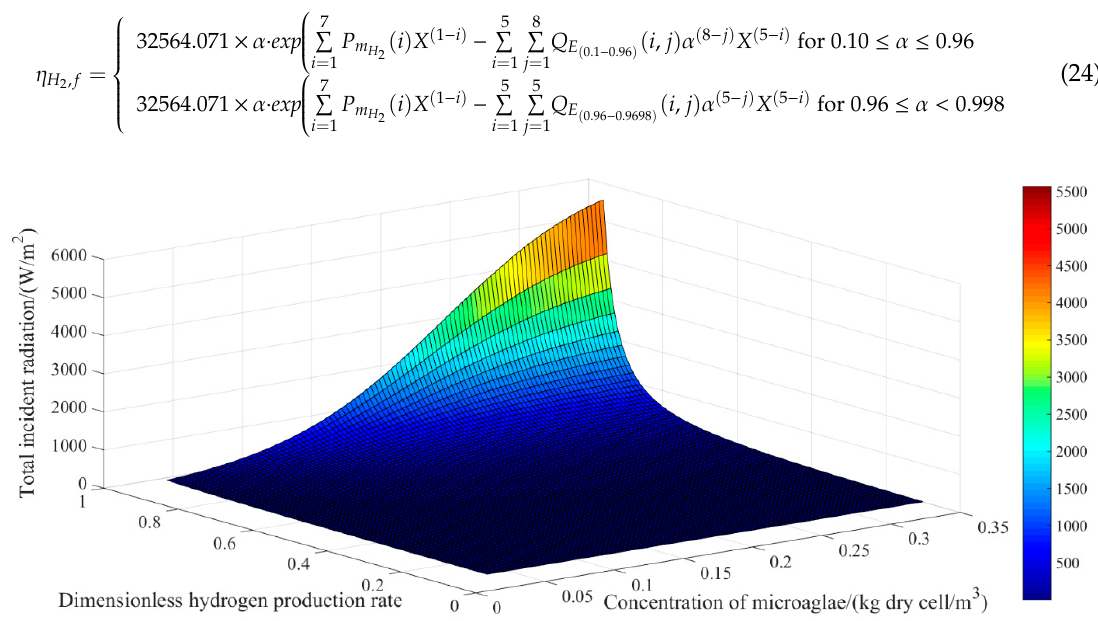
Figure 11. The performance surface of total incident radiation with the dimensionless hydrogen production rate (0.1–0.96) and the microalgae concentration.